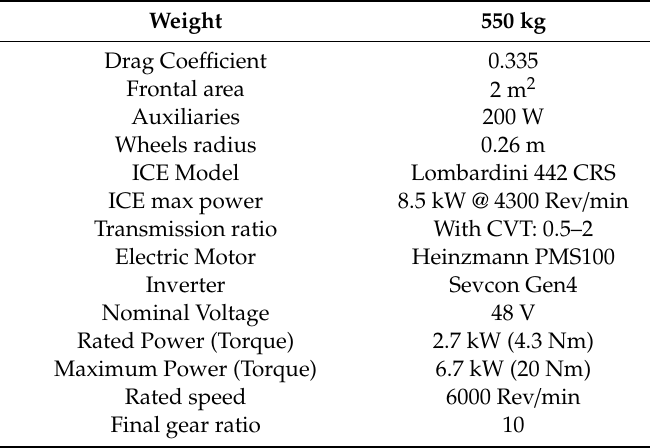
Figure 1. ( a ) Erad Spazia Quadricycle; ( b ) the hybrid powertrain scheme [15].